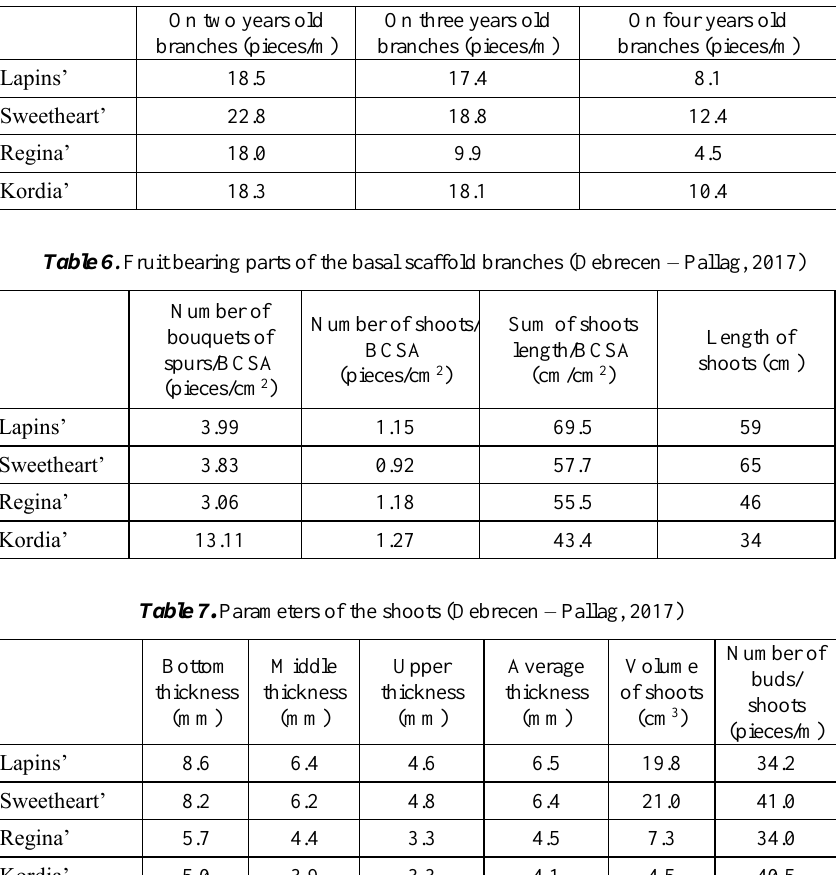
Table 5. Number of bouquets of spurs on the branches with different age (Debrecen – Pallag, 2017)